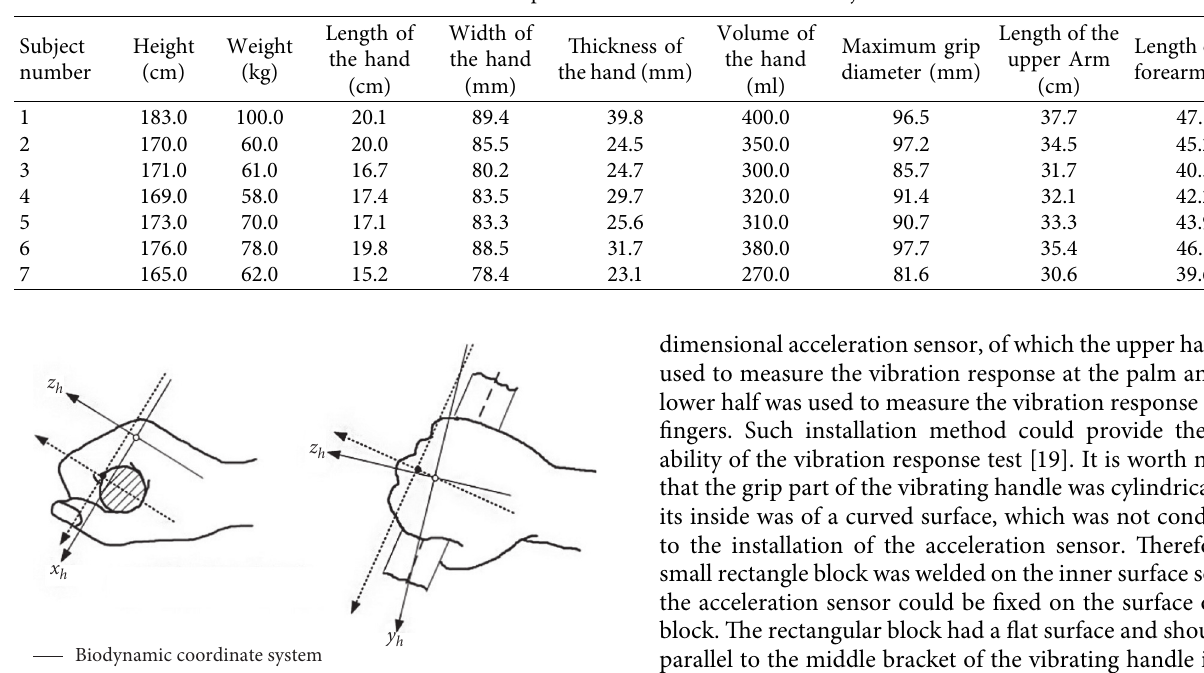
Table 1: Anthropometric measurements of the subjects.